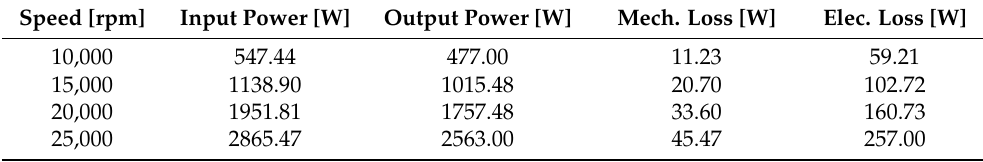
Table 4. Measurement results of input power, output, mechanical loss, and electromagnetic